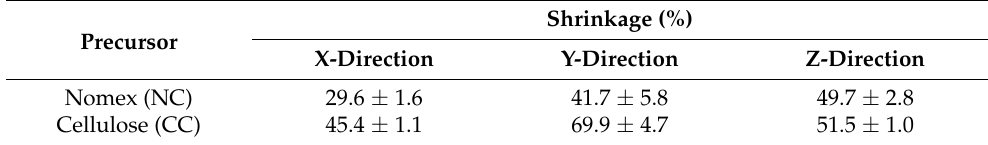
Table 1. Shrinkage values of carbon Miura-ori structures derived from Nomex and cellulose